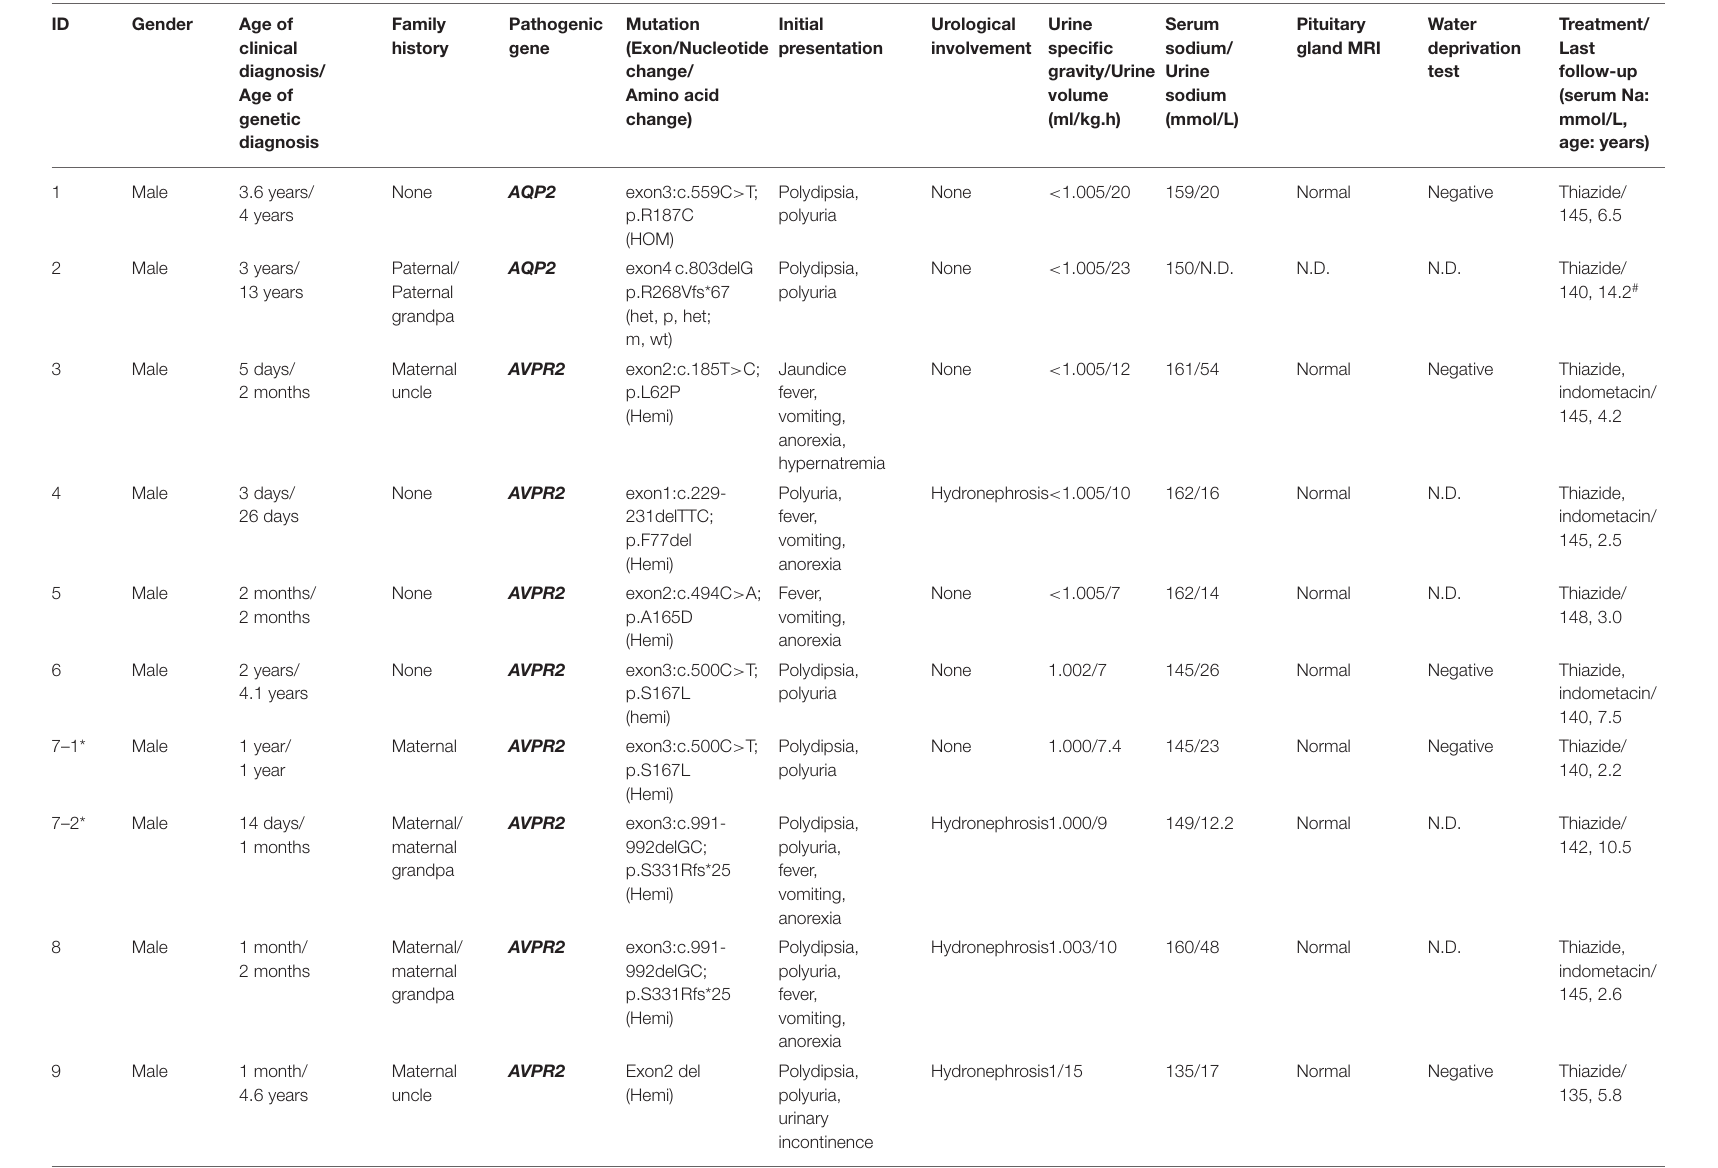
All patients with mutations in the AVPR2 gene were hemizygous segregated with all mothers were heterozygous for the given mutation. het, heterozygous; hemi, hemizygous; m, maternal; N.D., no data; p, paternal; * siblings. #the patient developed into CKD 3 stage at 14 years